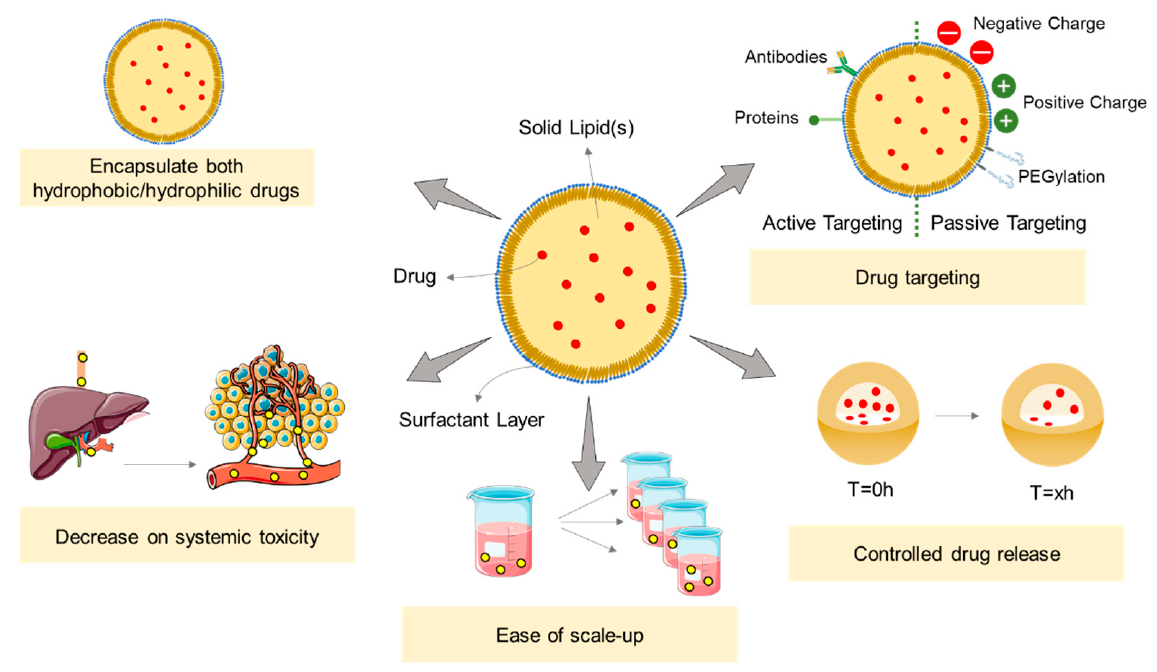
Figure 4. Highlight the applications of SLNs and their major advantages. SLNs could be used as a drug carrier for both hydrophobic and hydrophilic drugs, capable of controlling the drug release, avoiding the “burst effect”, and additionally promoting a target delivery that decreases the systemic toxicity. These nanocarriers could be easily scaled up in a cost-effective manner. Adapted from [116].